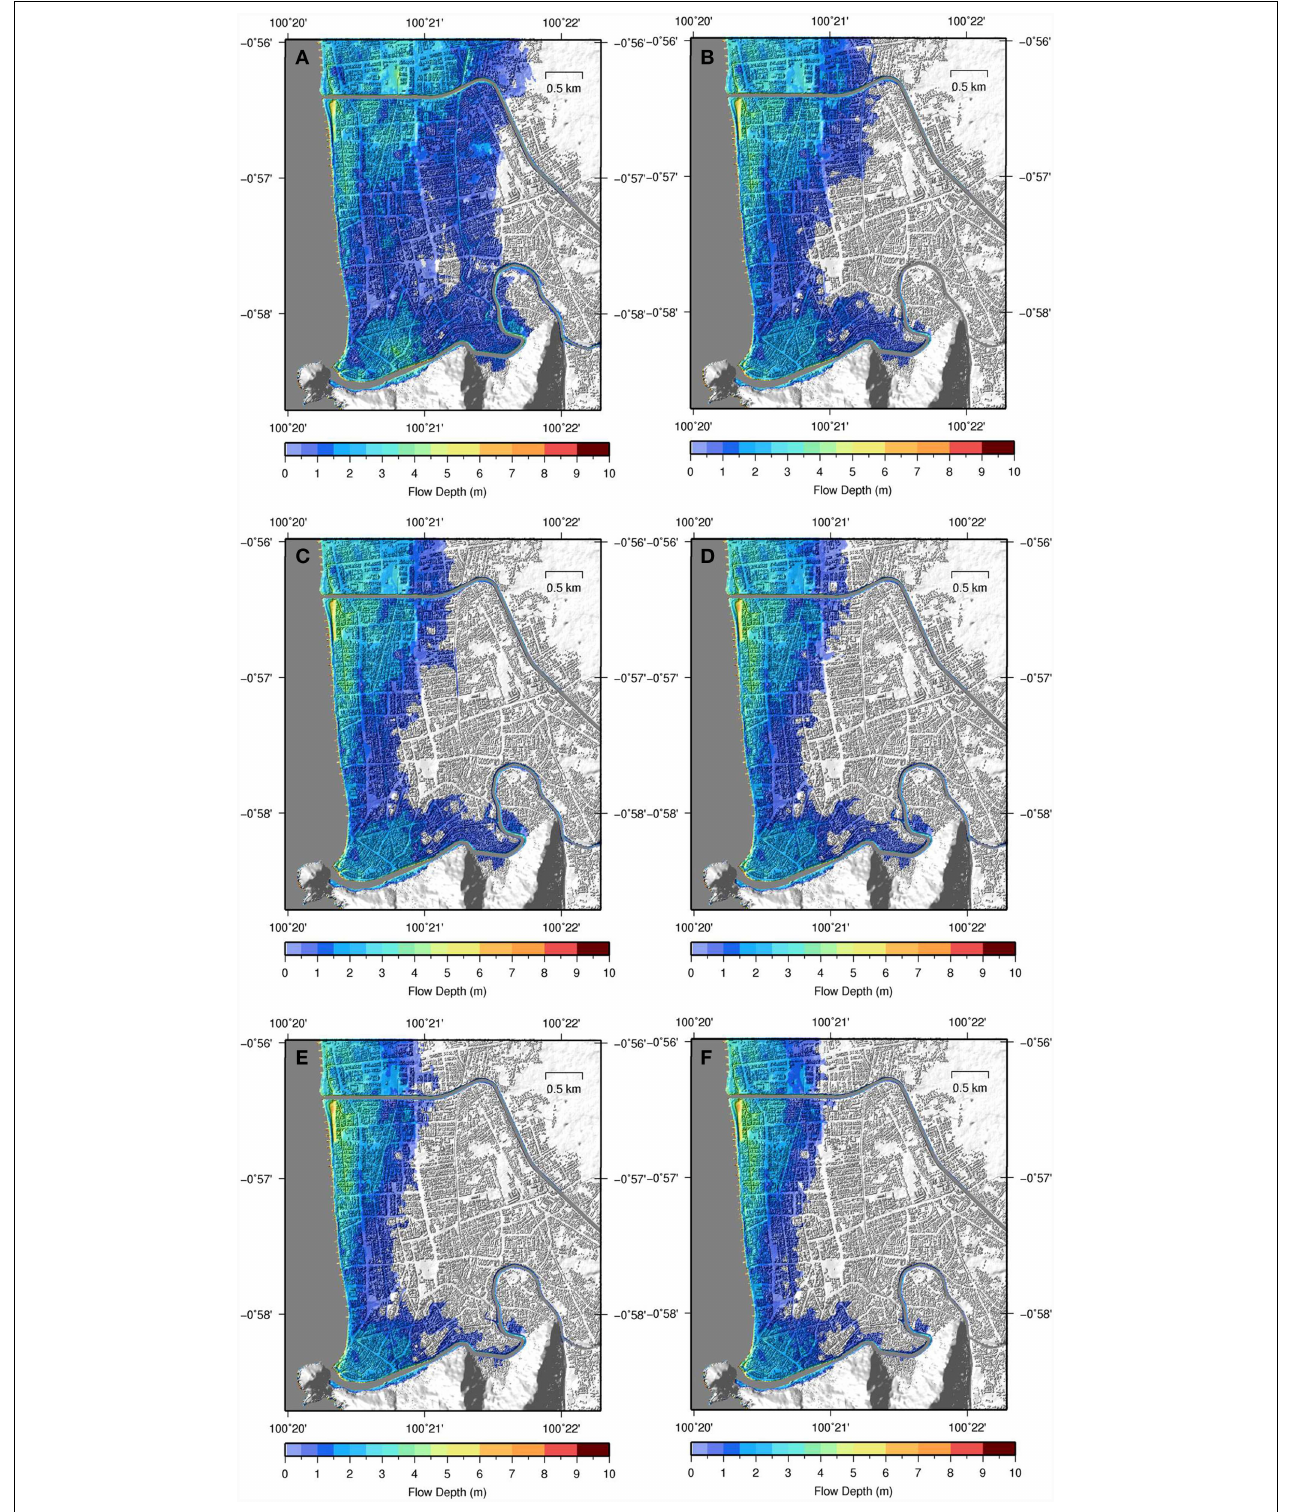
FIGURE 13 | Comparison between ANUGA inundation models for Padang for LiDAR DTM using onshore Manning’s n -values of (A) 0.01; (B) 0.025; (C) 0.04; (D) 0.06; (E) 0.08, and (F) 0.1. Mesh resolution is 7.62.